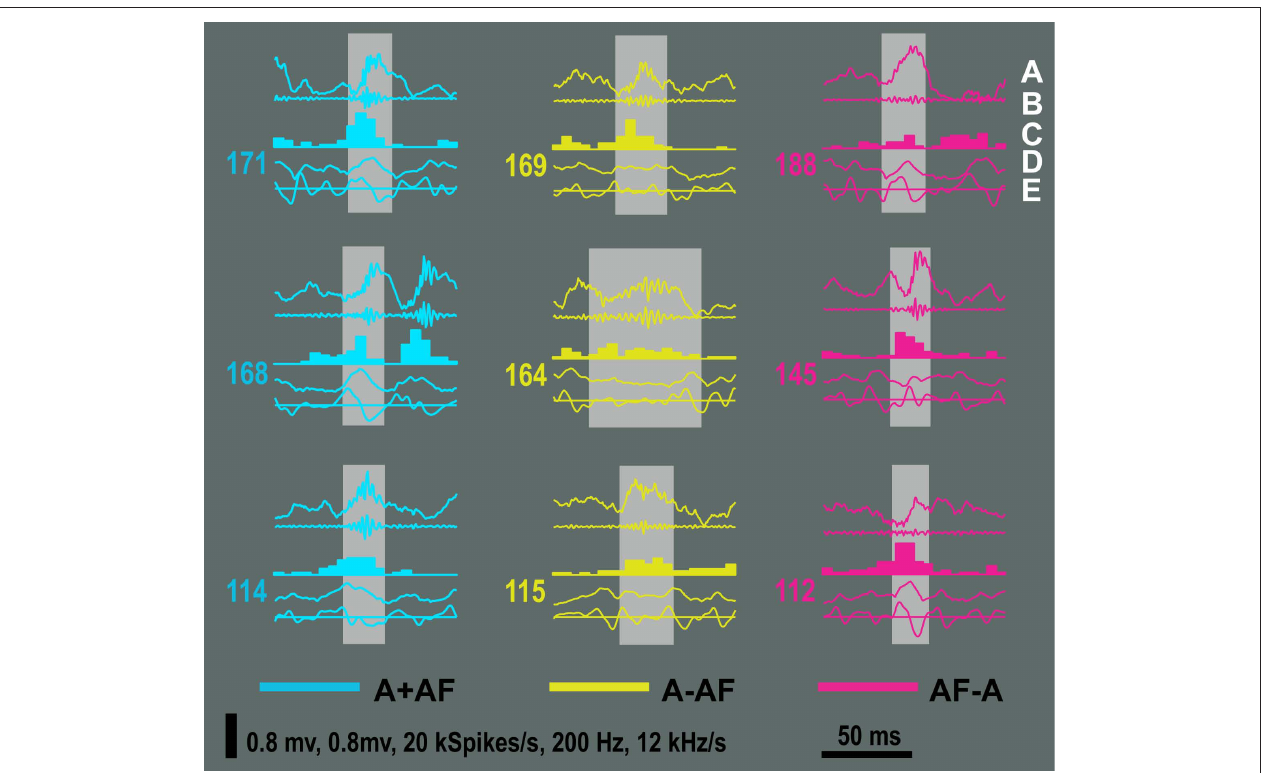
FIGURE 10 | Examples of ripples from the mutually inclusive (A + AF) and mutually exclusive categories (A − AF and AF − A). The order of the traces for each example is (A) Raw LFP, (B) ripple band signal, (C) multi-unit activity, (D) iFreq signal, and (E) FM signal. The horizontal line in (E) marks 0 kHz/s. Each example is 100 ms in